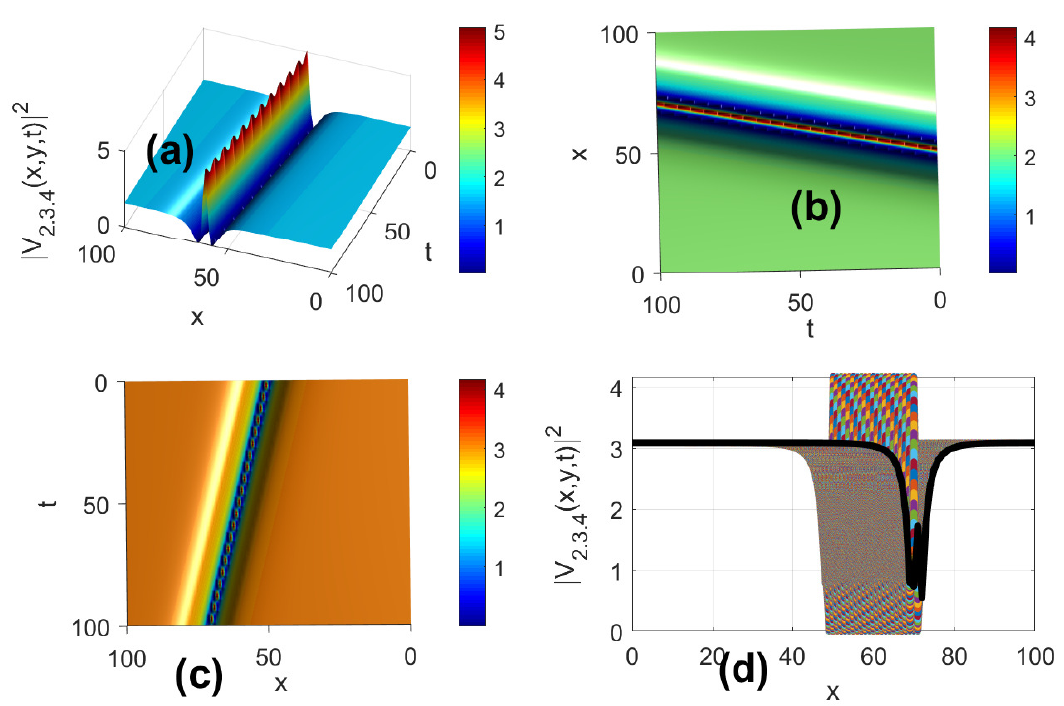
Figure 7. W-SS with the effects of the NELT parameters. The parameters used are p = q = 1, ϑ 0 = 0.1, y = 0.42, B 0 = − 0.02, B 1 = − 0.1, B 2 = − 4.02, ϑ = 0.21, λ 2 = − 0.45, λ 4 = 0.02, α = 0.1 V − 1 , β = 0.019 V − 1